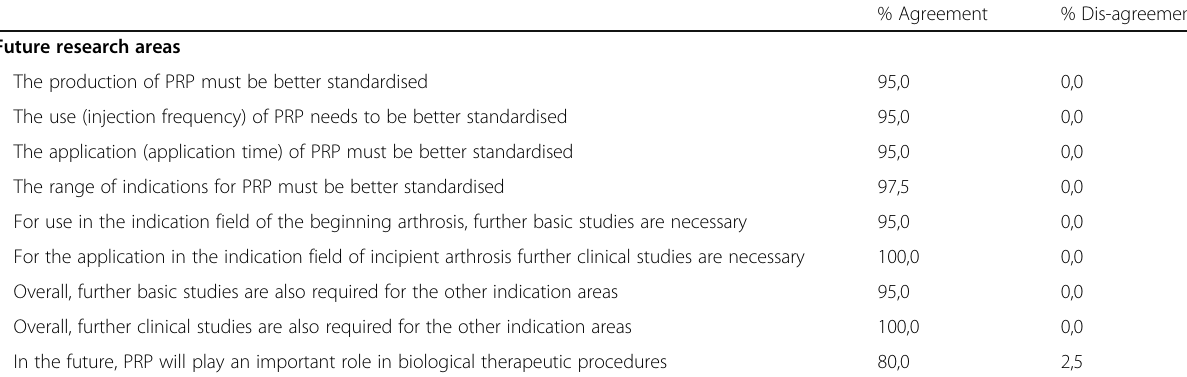
Table 5 Main future research